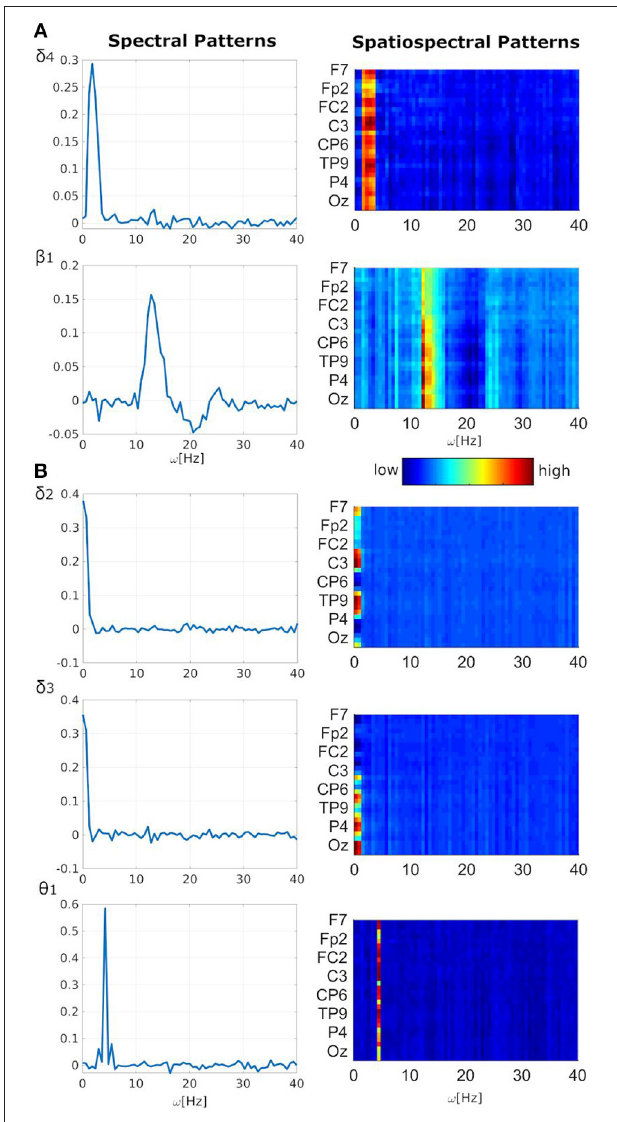
FIGURE 1 | Task-related EEG spectral or spatiospectral patterns. (A) Frequent related; (B) target related. Pattern shortcuts and indexes (e.g., δ 4 ) are the same as used in (19) for consistency purposes. All spectral patterns are averages over electrodes of both absolute or relative spatiospectral patterns. Patterns’ amplitudes (i.e., y-axis for spectral patterns and color-coding for spatiospectral patterns) are in arbitrary units. For spatiospectral patterns, the dark blue color is an approximate minimum value in the y-axis of the corresponding spectral pattern. The dark red color is an approximate maximum value in the y-axis of the corresponding spectral